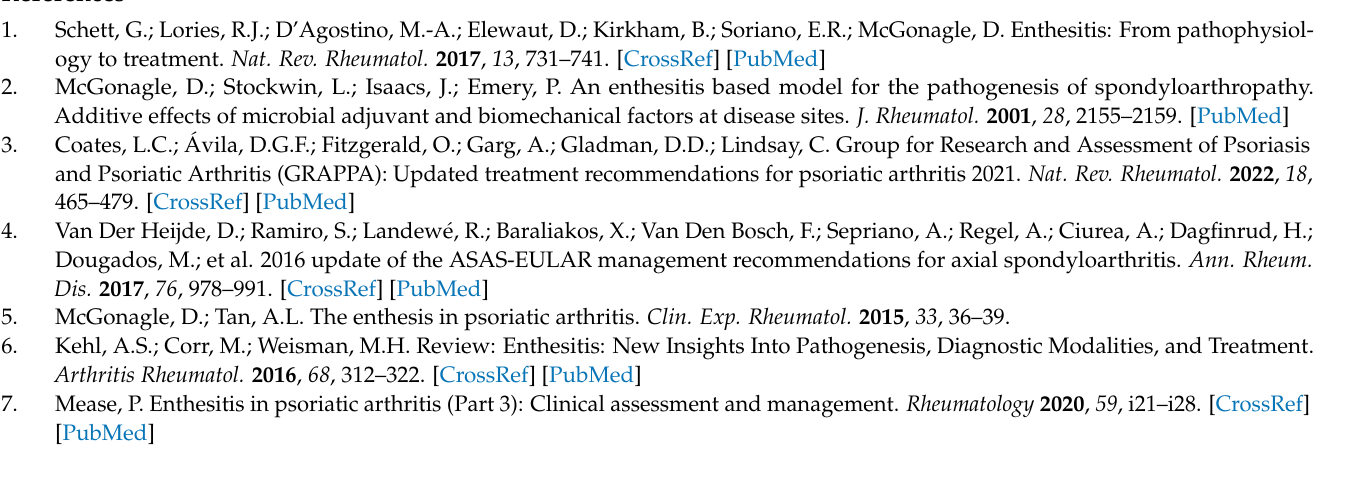
Supplemental Table S3: Change in HEMRIS subscores after longitudinal follow-up; Supplemental Figure S1: Flowchart; Supplemental Figure S2: Change in the HEMRIS in Pso patients with and without progression to